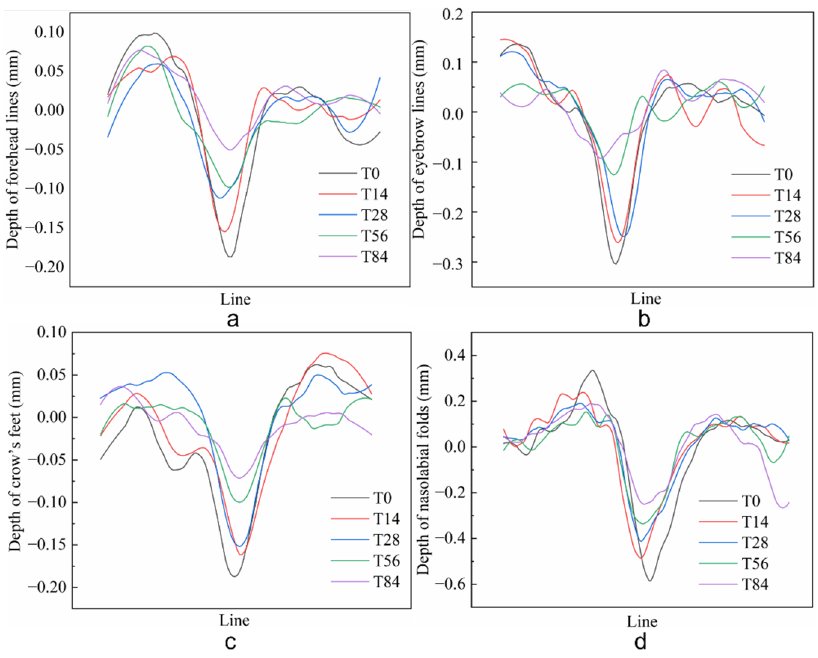
Figure 7. The topical line analysis images of forehead lines ( a ), eyebrow lines ( b ), crow’s feet ( c ), and nasolabial folds ( d ) with continuous administration for 84 days.